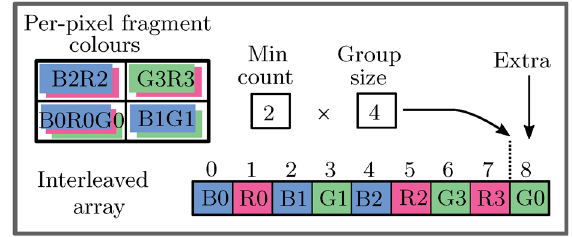
Fig. 5 Per-pixel blue/red/green, blue/green, blue/red, and green/red fragment colours as an interleaved array.